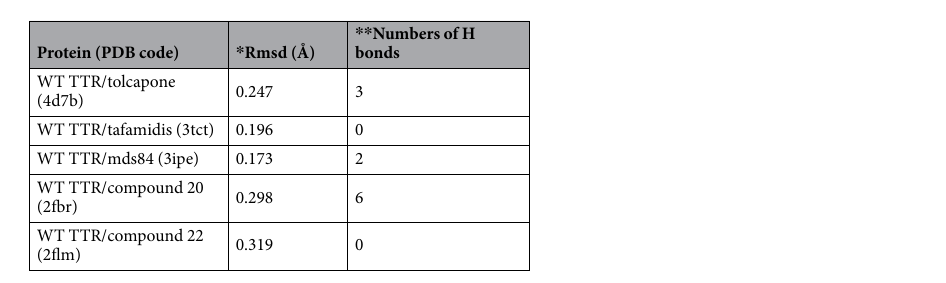
Table 1. Structural comparisons of TTR halogen binding pockets with and without ligands. * The root mean square deviation was calculated for the backbone atoms of all the three HBPs for the wild type TTR complexes compared to the same protein without ligand (PDB 1dvq). ** The hydrogen bonds considered are those between the ligand and the HBPs atoms including crystallographic water